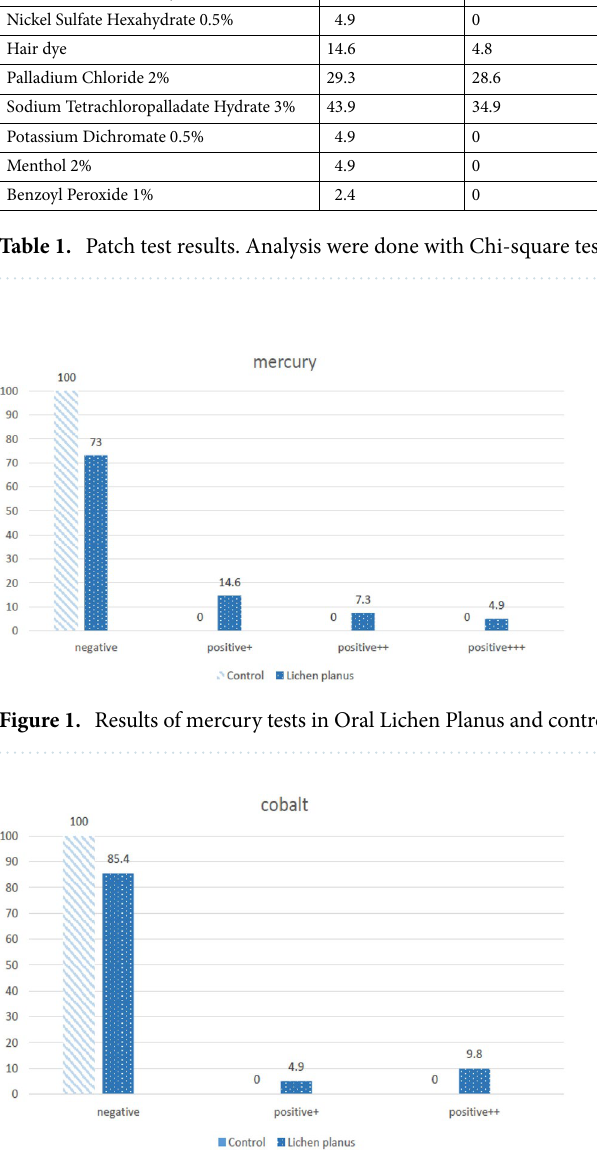
Figure 2. Results of cobalt tests in Oral Lichen Planus and control